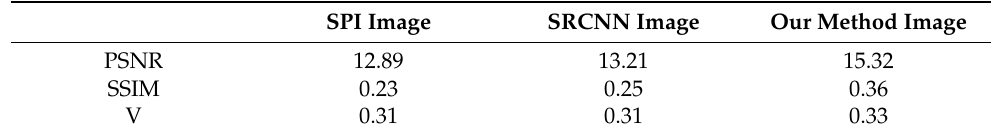
Table 5. The respective PSNR and SSIM for different methods (object